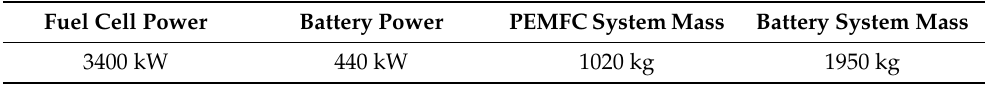
Table 11. Result of powertrain sizing regarding the power and